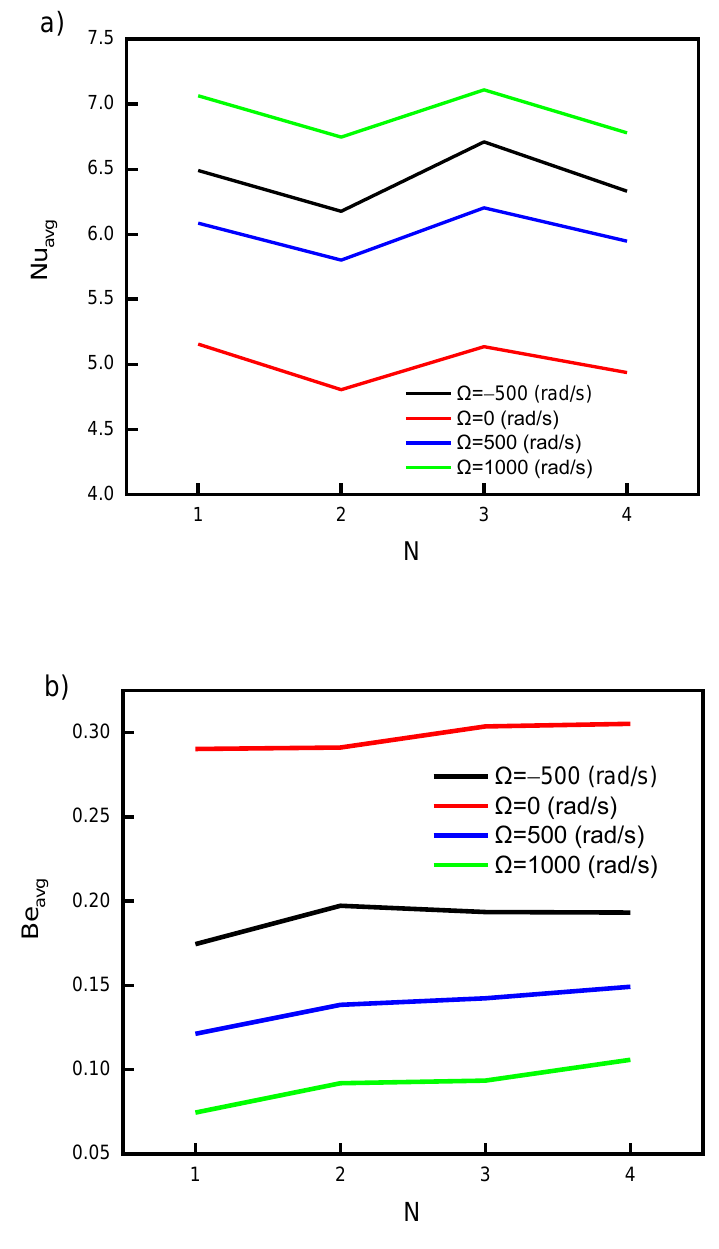
Figure 9. Influence of the number of undulations on ( a ) Nu avg and ( b ) Be avg for different cylinder rotating speeds.